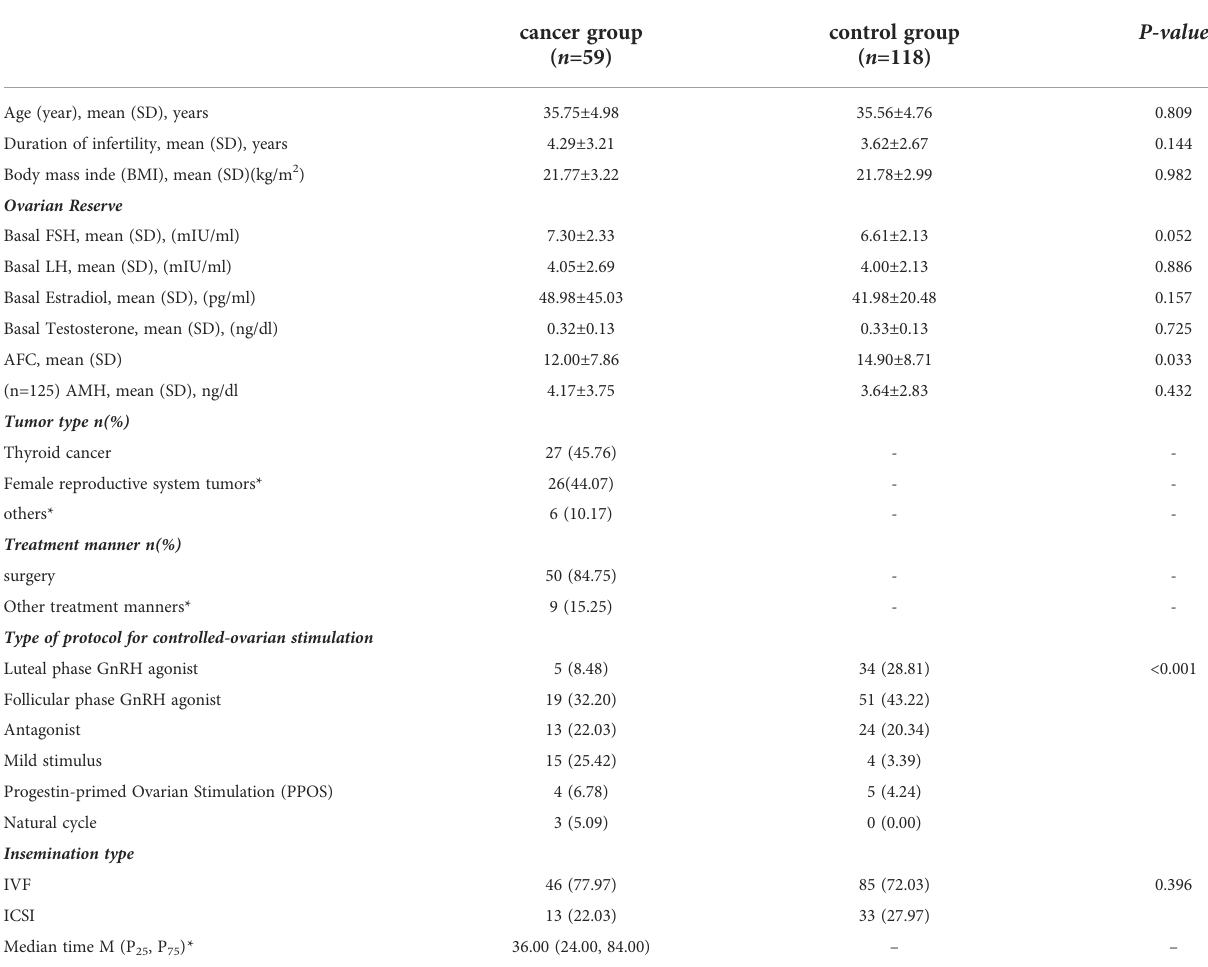
TABLE 1 Patients ’